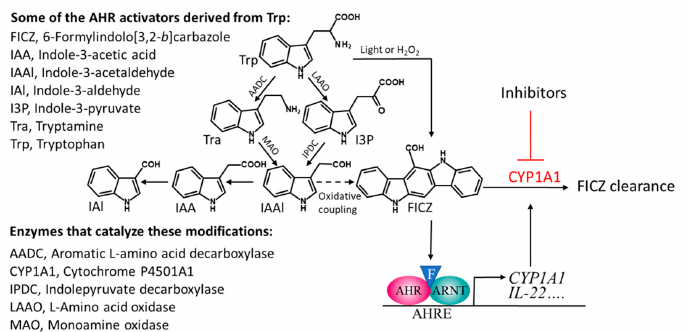
Figure 1. A scheme describing the microbiota-mediated catabolism of tryptophan that leads to several compounds that can activate the aryl hydrocarbon receptor (AHR), including the high affinity ligand FICZ (illustrated by an F in a blue triangle). Stimulation with FICZ causes AHR to partner with the nuclear translocator of AHR (ARNT), bind to AHR response elements (AHREs), and stimulate expression of CYP1A1, which takes part in the metabolic clearance of FICZ. The oxidative coupling that generates FICZ from IAAl has been described in [5]. Another group of AHR activators produced by the gut microbiota encompass the SCFAs acetate, propionate and butyrate (BUT), of which the role of BUT in maintaining intestinal immune homeostasis is most well documented. BUT is derived from microbial fermentation of indigestible polysaccharides, in particular dietary fibers and resistant starch, which escape digestion by enzymes in the upper gut and are consequently present at relatively high levels (mM) in the lumen of the lower gut (reviewed in [54]). In addition to providing an important source of energy for colonocytes, BUT inhibits inflammation of the intestine and promotes the development and function of Tregs in a beneficial manner. Many of the anti-inflammatory properties of BUT reflect its inhibition of histone deacetylases (HDACs) and simultaneous activation of certain G-protein-coupled receptors on colonic